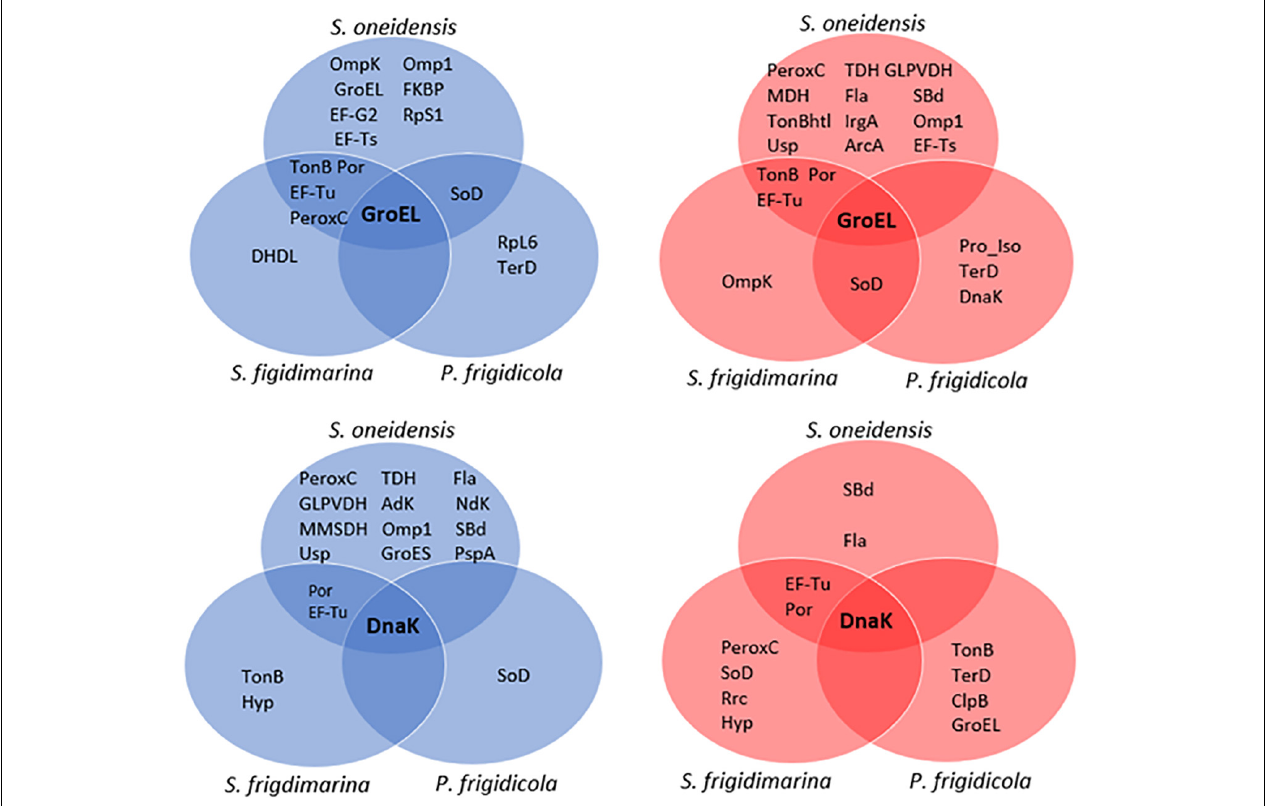
FIGURE 4 | Venn diagrams of identified proteins that coimmunoprecipitate with GroEL (top) and DnaK (down) in the three bacteria at 4 (blue) and 30 ◦ C